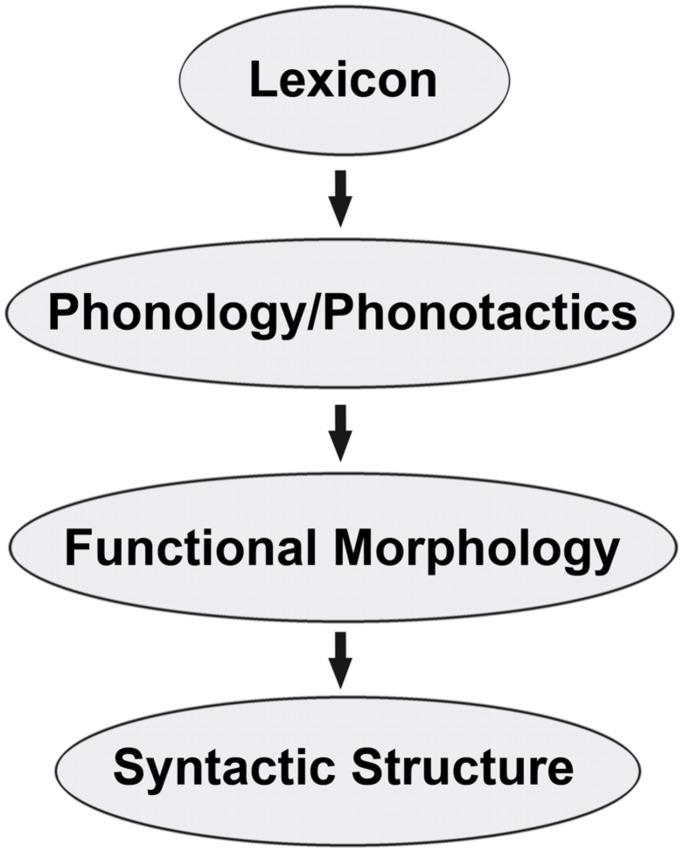
Implicational hierarchy of input cues. Adapted from Rothman (2013, 2015).